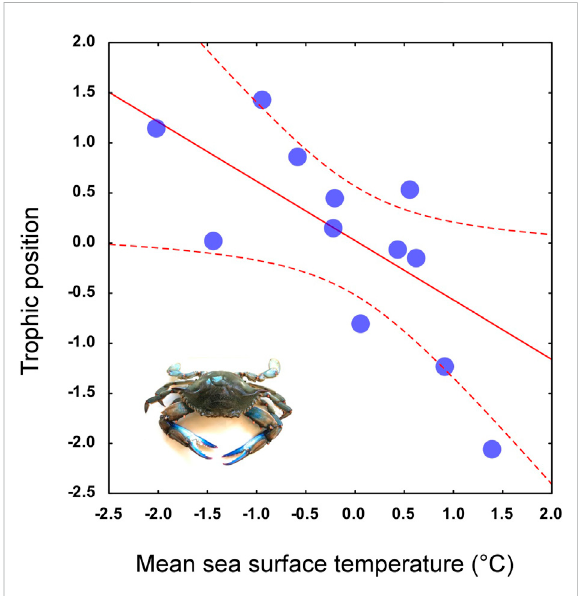
FIGURE 7 Trophic position of Callinectes sapidus calculated from the individual-scale dataset as predicted by local annual mean sea surface temperature. For the regression curve (solid line) 95% con fi dence intervals are included (dashed line). Log- transformed and mean-centered data are used in the scatterplot.